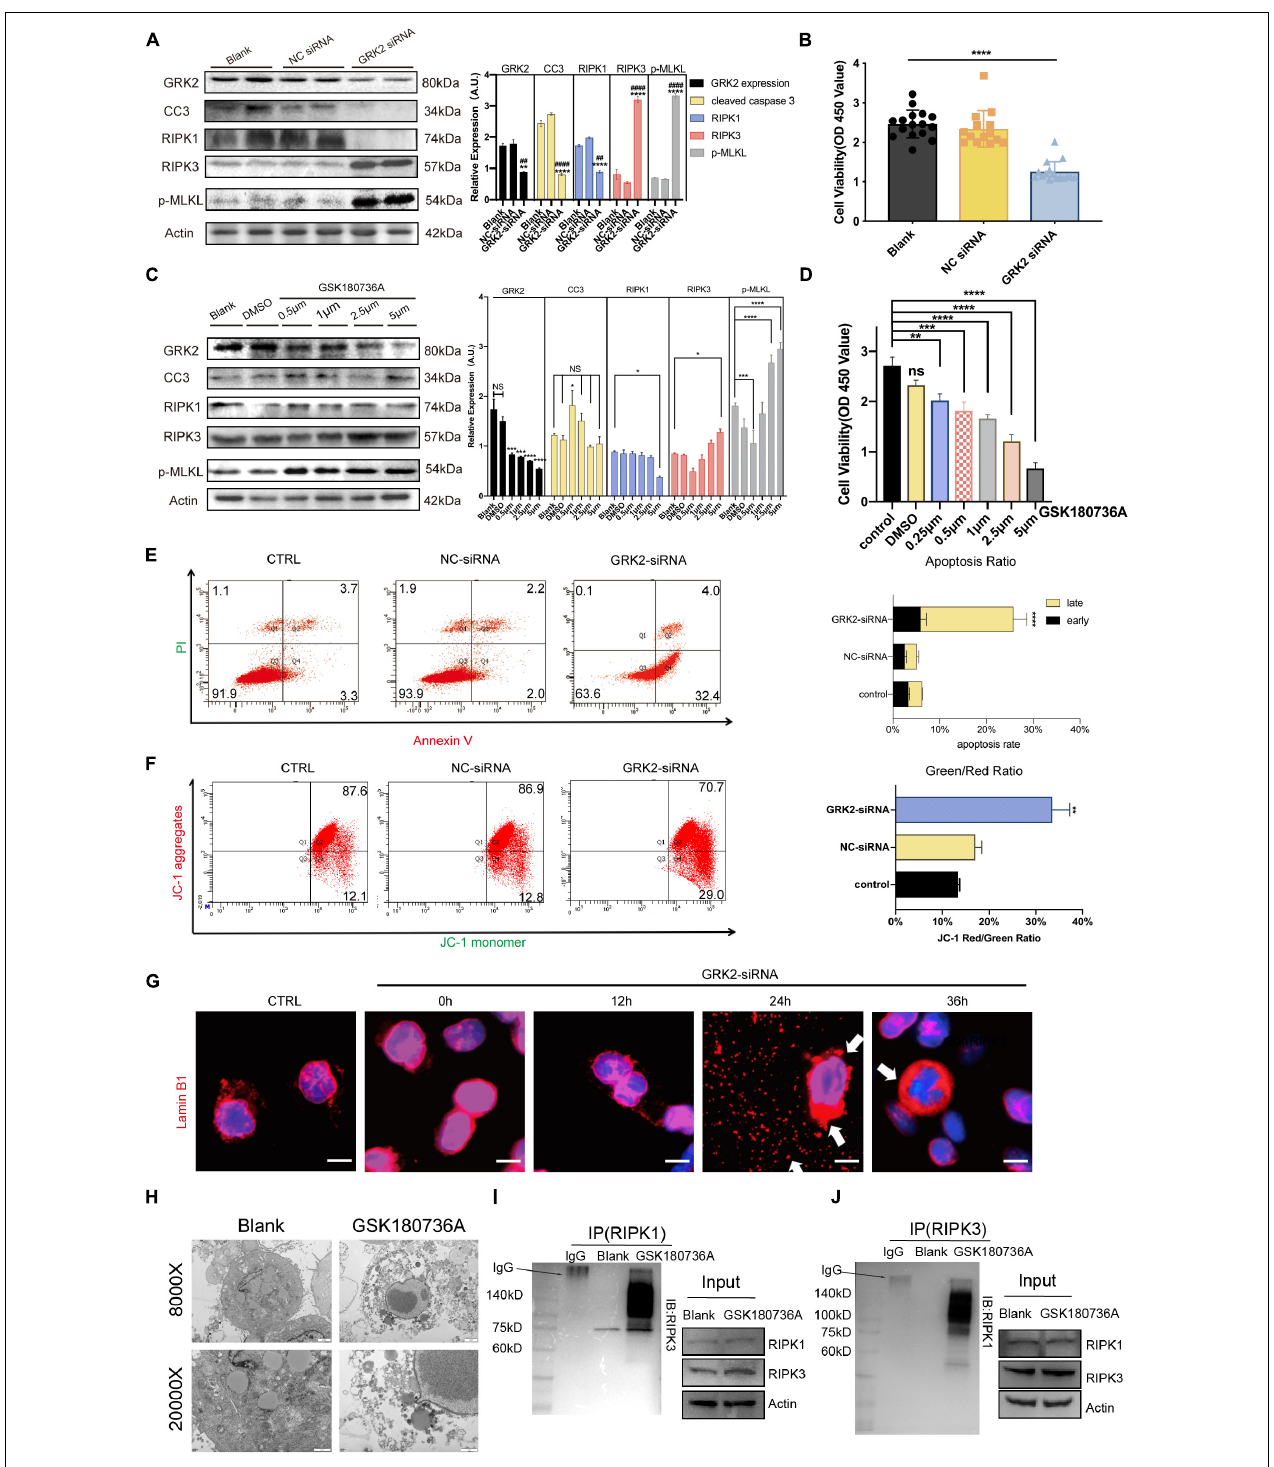
FIGURE 5 | Knockdown or inhibition of GRK2 induces RIPK1/RIPK3-dependent necroptosis in HTR8/SVneo cells. (A) HTR8/SVneo cells are transfected with non-targeted siRNA (NC-siRNA) or siRNA targeted to GRK2 (GRK2-siRNA) for 48 h. Representative western blot analysis of cleaved-caspase 3, RIPK1, RIPK 3, phospho-MLKL (p-MLKL; S358), and β -actin (loading control). (B) Cell viability is assessed using CCK8 assay after transfection with siRNA for 48 h. Values are expressed as Mean ± SEM. (C) Pharmacologic inhibition of GRK2 in HTR8/SVneo cells by GSK180736A at different concentrations (0.5, 1, 2.5, and 5 µ M) for 12 h. Representative western blot analysis of cleaved-caspase 3, RIPK1, RIPK 3, phospho-MLKL (p-MLKL; S358), and β -actin (loading control). (D) Cell viability is